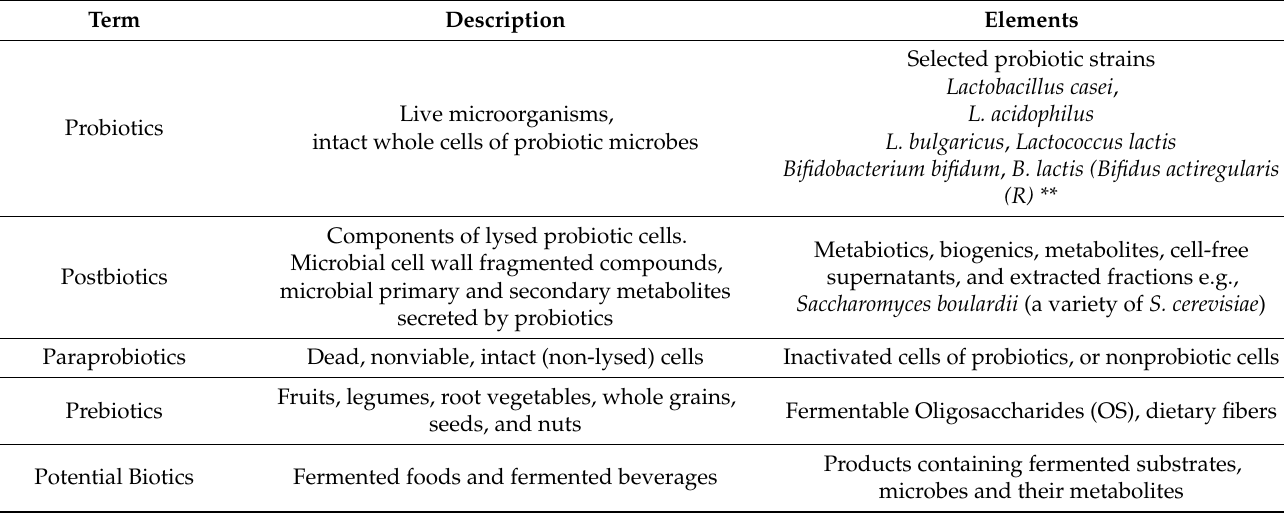
Table 1. Description of terms related to nutrition and health (source of information compiled in the table from references